Question: In a single sentence, describe what this figure presents.
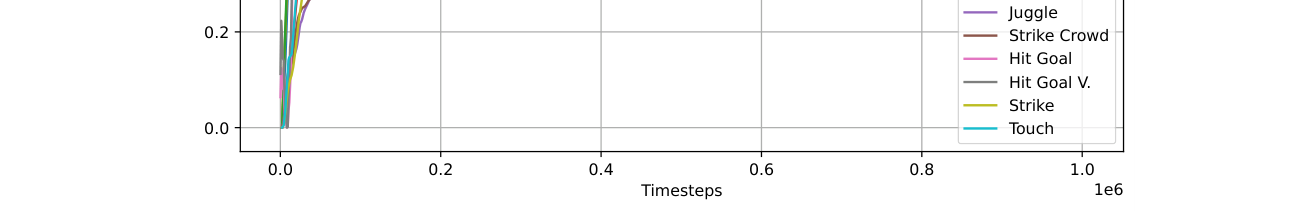
Answer: Training curve for all tasks in Box2D. For vanilla RL tasks, the rewards are averaged across 5 seeds, while for goal-conditioned RL we use 1 seed. Rewards are then normalized to to the [0, 1] range with respect to the minimum and maximum reward seen for each task. Tasks in which performance converges quickly indicate that the task is either trivially easy (reaching a position with the paddle, reaching a position with the paddle with a desired velocity) or too difficult (moving a block, hitting a puck into a goal position with desired velocity).